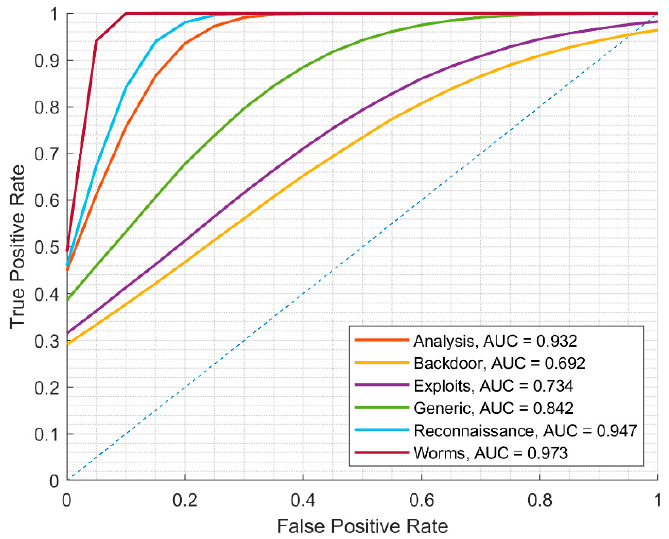
Figure 13. ROC curve using ML.NET created model on UNSW-NB15 training dataset for attacks